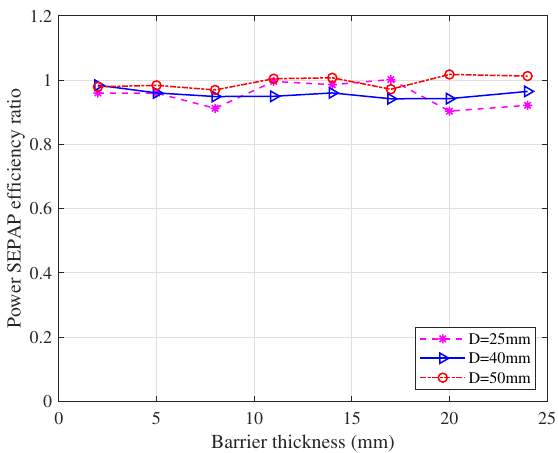
Figure 12. The ratio between SEPAP transfer efficiency and power transfer